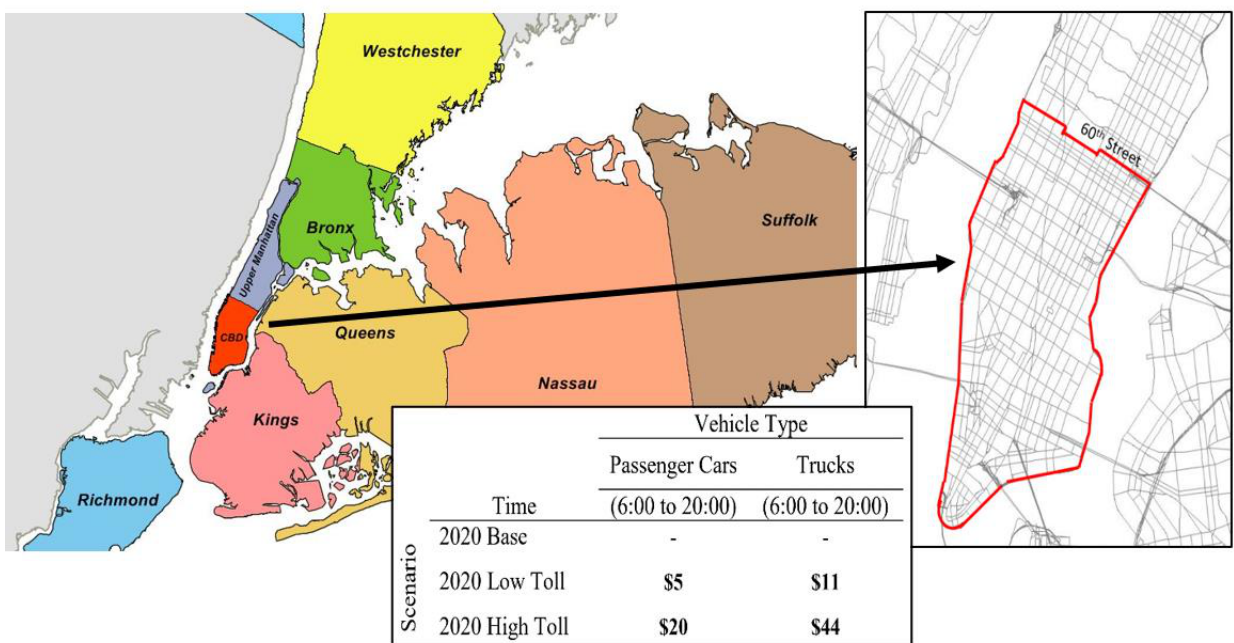
Figure 5. Study area and toll values for cordon pricing scenarios .